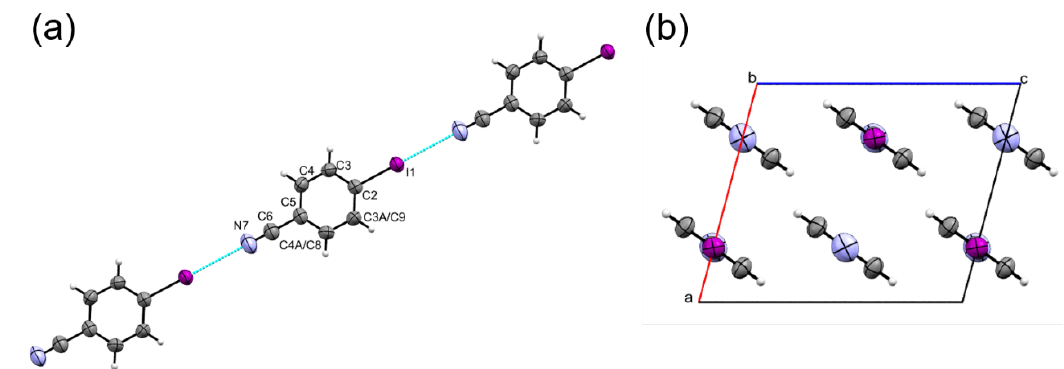
Figure 1. ( a ) ORTEP style plot of 4-iodobenzonitrile and the numbering scheme used in this study. The atom numbering scheme in phase II is the same as that of phase I but the symmetry generated C3 and C4 become C9 and C8, respectively. Ellipsoids are drawn at the 50 % probability level. ( b ) Molecular chains formed along b surrounded by six neighbouring chains.